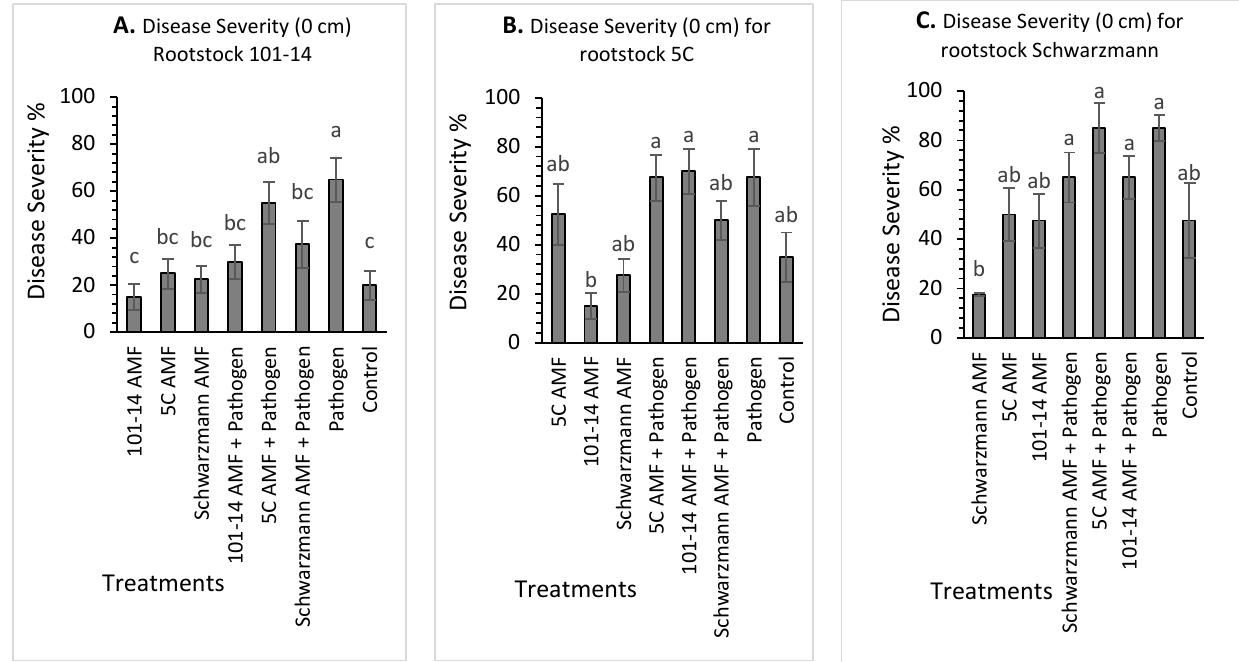
Figure 7. Mean black foot disease severity (%) for rootstocks 101-14 ( A ), 5C ( B ) and Schwarzmann ( C ) at 0 cm from stem base colonized with different AMF communities originating from different rootstocks (101-14, 5C and Schwarzmann) and inoculated with black foot pathogen isolates. Bars with different letters are significantly different ( p ≤ 0.05) based on the SED generated from GLM analysis. Error bars show ± SED.